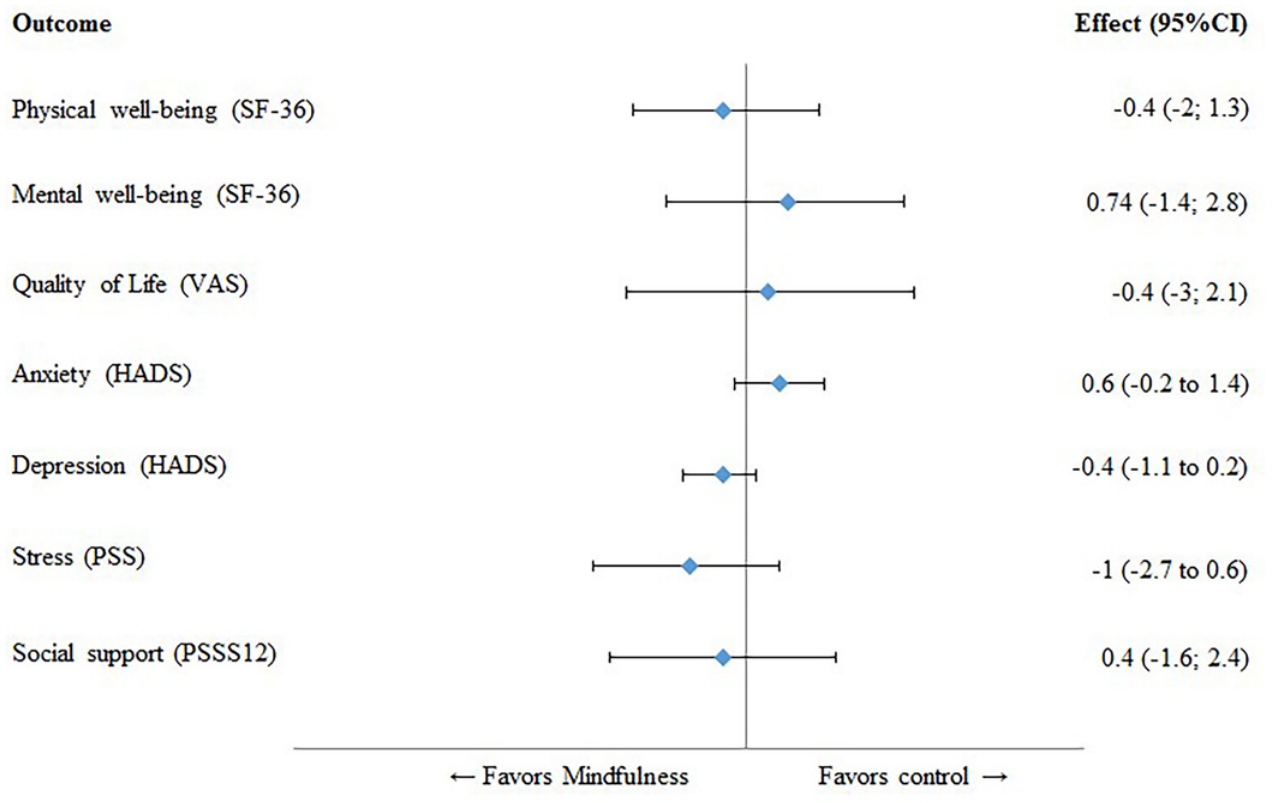
Fig 3. Forest plot of psychological outcomes. All values on the left of the Y-axis indicate a difference in favour of the mindfulness group. CI, confidence interval; SF-36, Short Form Health survey; VAS, visual analogue scale; HADS, hospital anxiety and depression scale; PSS, perceived stress score; PSSS12, perceived social